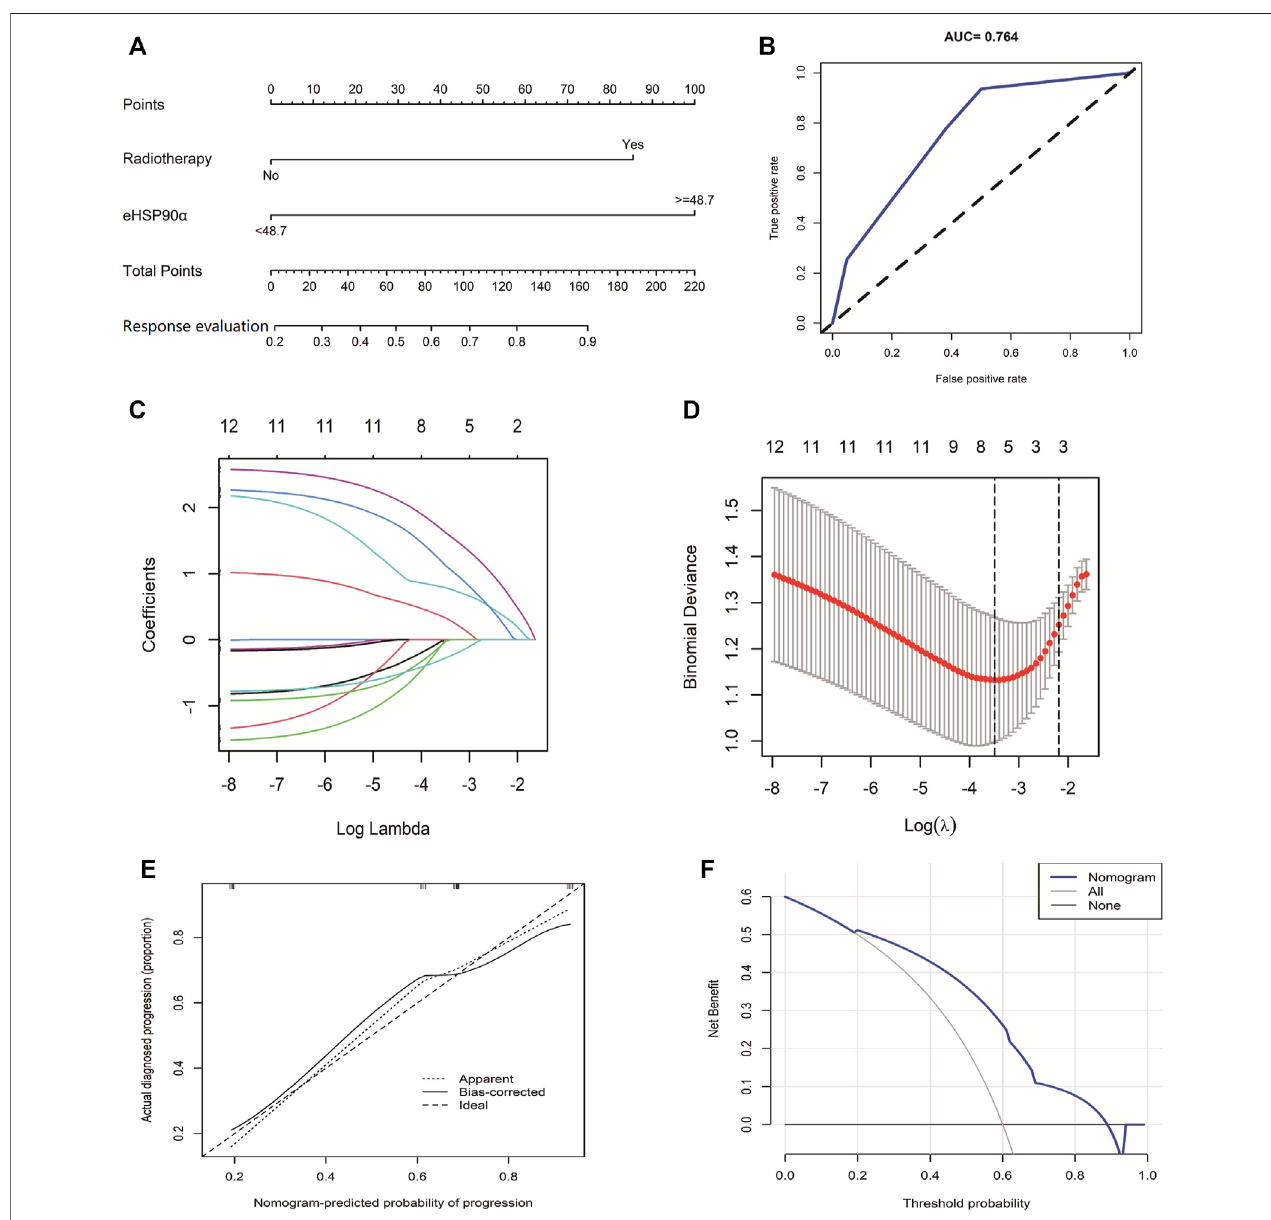
FIGURE 3 | The Predictive Value of eHSP90 α for SCLC effective chemotherapy (A) Established small cell lung cancer response evaluation nomogram with eHSP90 α (B) Receiveroperatingcharacteristiccurveofthemodel (C) LASSOcoef fi cientpro fi lesofthe12features (D) Acoef fi cientpro fi leplotwasproducedagainstthe log λ sequence (E) Calibration curves of the nomogram. Notes: The x -axis represents the predicted probability of progression. The y -axis represents the actual progression of small cell lung cancer. The diagonal dotted line represents a perfect prediction by an ideal model. The solid line represents the performance of the nomogram, of which a closer fi t to the diagonal dotted line means a better prognosis (F) Decision curve analysis of our model showed that response evaluation nomogram. The x-axis is the risk threshold probability that changes from 0 to 1, and the y-axis is the calculated net pro fi t for a given threshold probability.